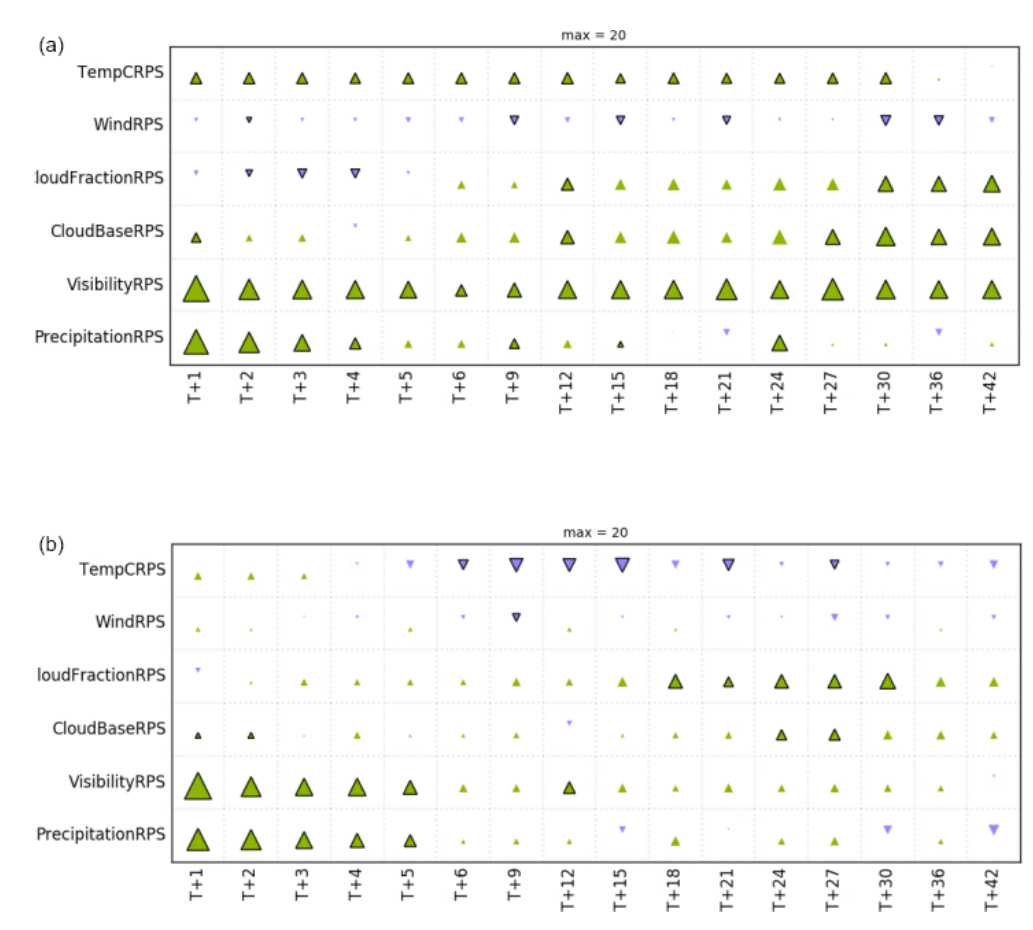
Figure 11. MOGREPS-UK trials: RAL2-M vs. RAL1-M HiRA summary scorecard at 15km (seven grid lengths) spatial scale for winter (a) and summer (b)